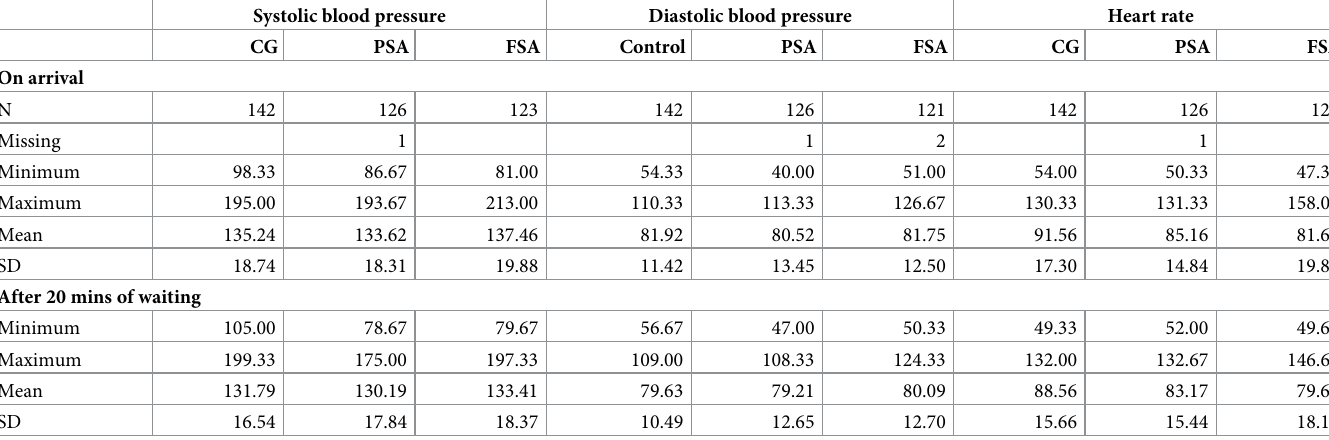
Table 3. Descriptive analysis showing the blood pressure (systolic, diastolic) and heart rate of the participants in the different waiting area settings.